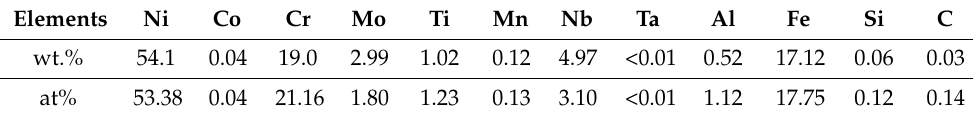
Table 1. Chemical composition of the Alloy 718 powder as provided by the powder producer. Elements